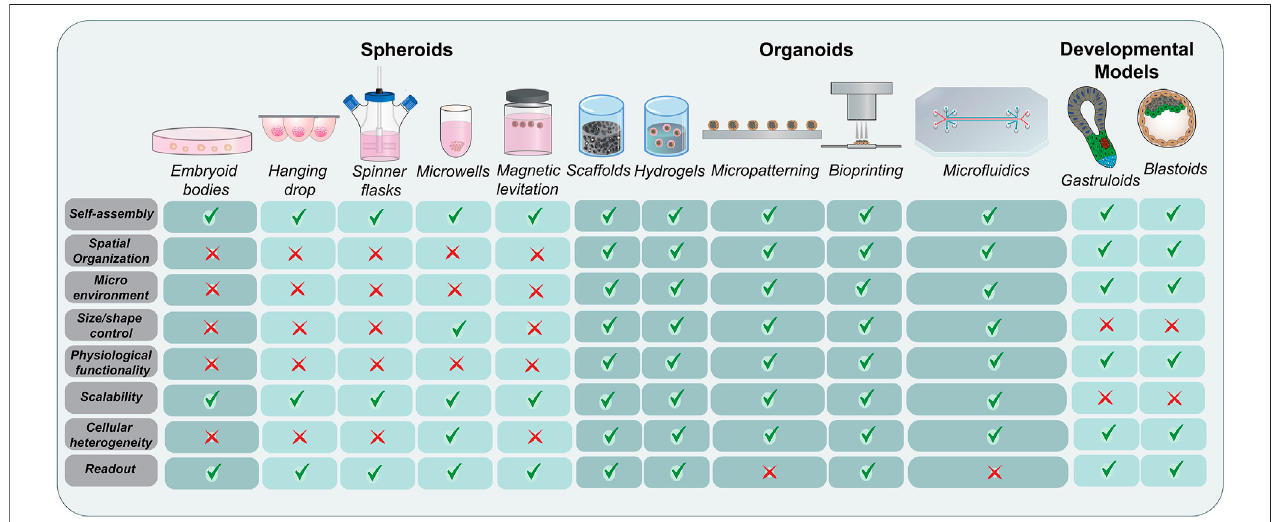
FIGURE2| Evolutionofstemcellorganizationtechniques.Acomprehensiveschematicrepresentingthemethodsusedfortheaggregationandself-organizationof stem cells starting with embryoid bodies and spheroids and moving to more complex organoids and developmental models. While the conventional methods rely more on aggregation techniques, the advanced bioengineered models focus on physiological relevance and complex spatial organization. The major advantages and limitations of these techniques have been